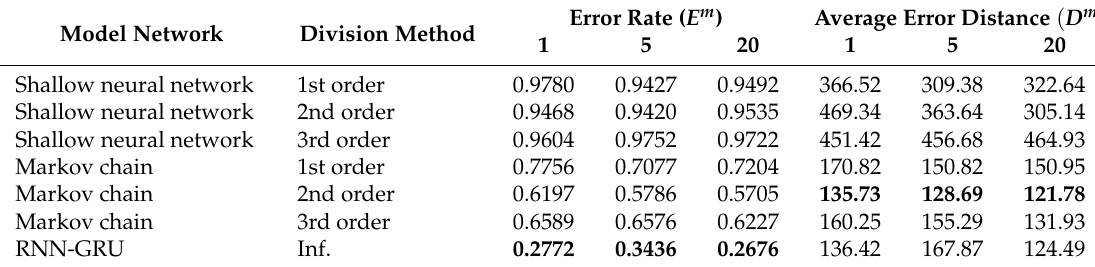
Table 2. Summary of cross-validation results for distinct model structures, where the bold numbers identify the best model according to the goodness-of-fit